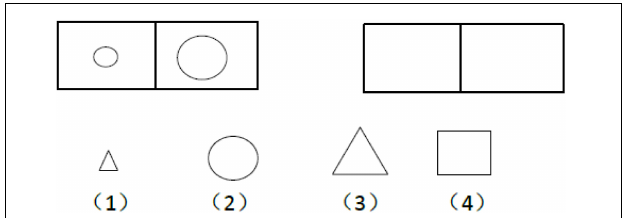
FIGURE 1 | Graphic analogical reasoning test.